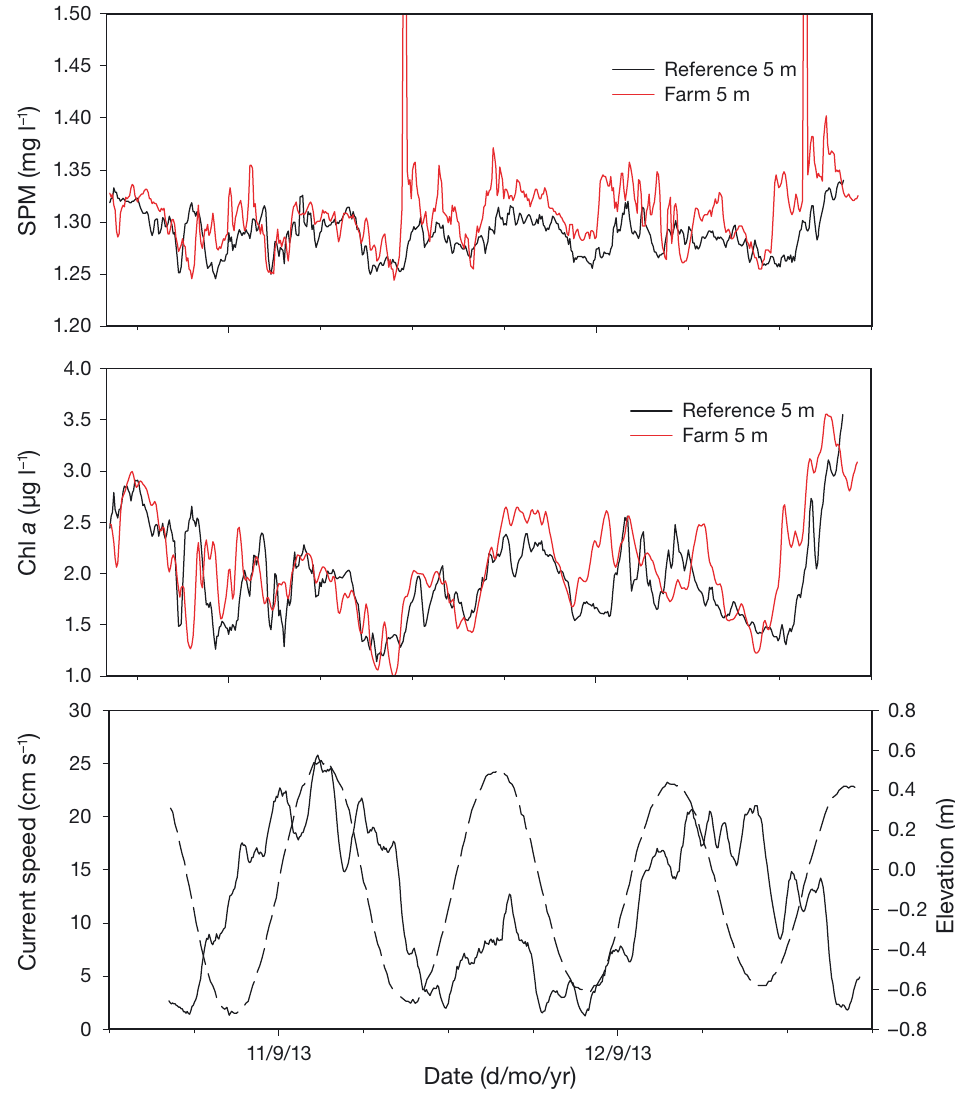
Fig. 5. Suspended particulate matter (SPM) and chlorophyll a (chl a ) concentrations and current speeds, collected at 5 min in- tervals at a depth of 5 m, at the farm (20 m from nearest salmon cage) and reference stations at the Flåtegrunnen salmon farm (Fig. 1). The dashed line is the measured tidal